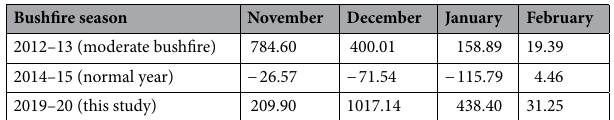
Table 2. Monthly average anomalies active fire points for the typical months in Australia.